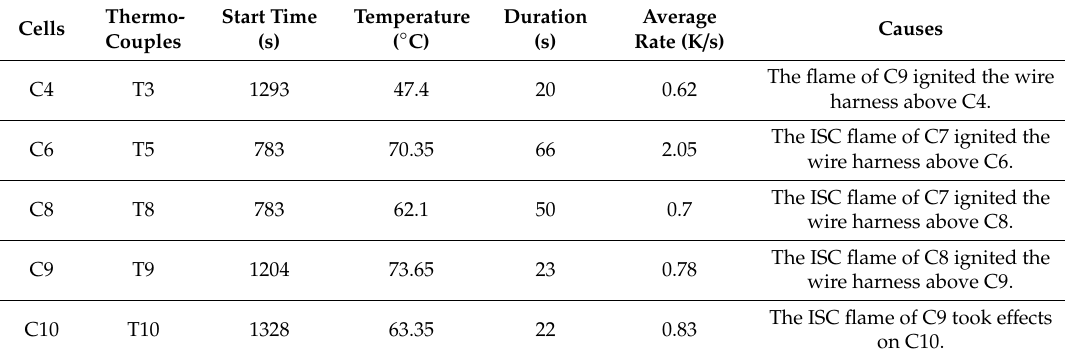
Table 5. High temperature rate intervals of 0.5 K / s by thermal runaway